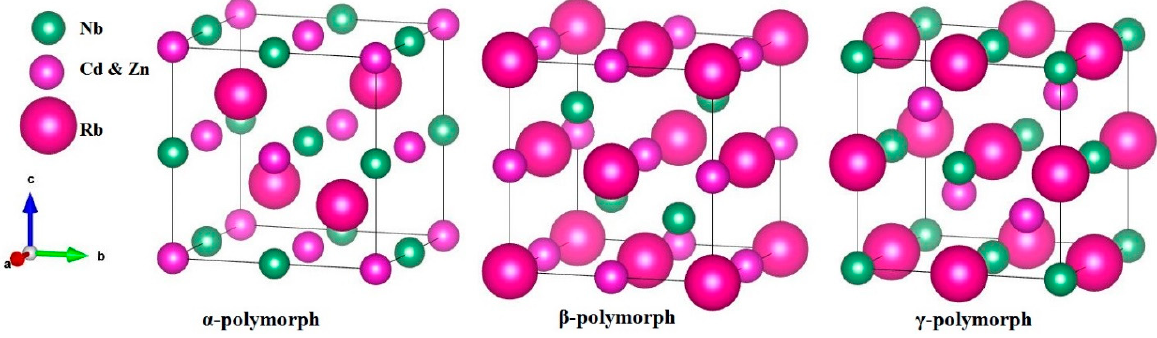
Figure 1. A view of the crystal structure of the RbNbCd and RbNbZn. Table 1. Computed lattice parameters, c/a ratio, bulk modulus (B), pressure derivative of the bulk modulus (B’), energy total (E) and energy formation (E form ).